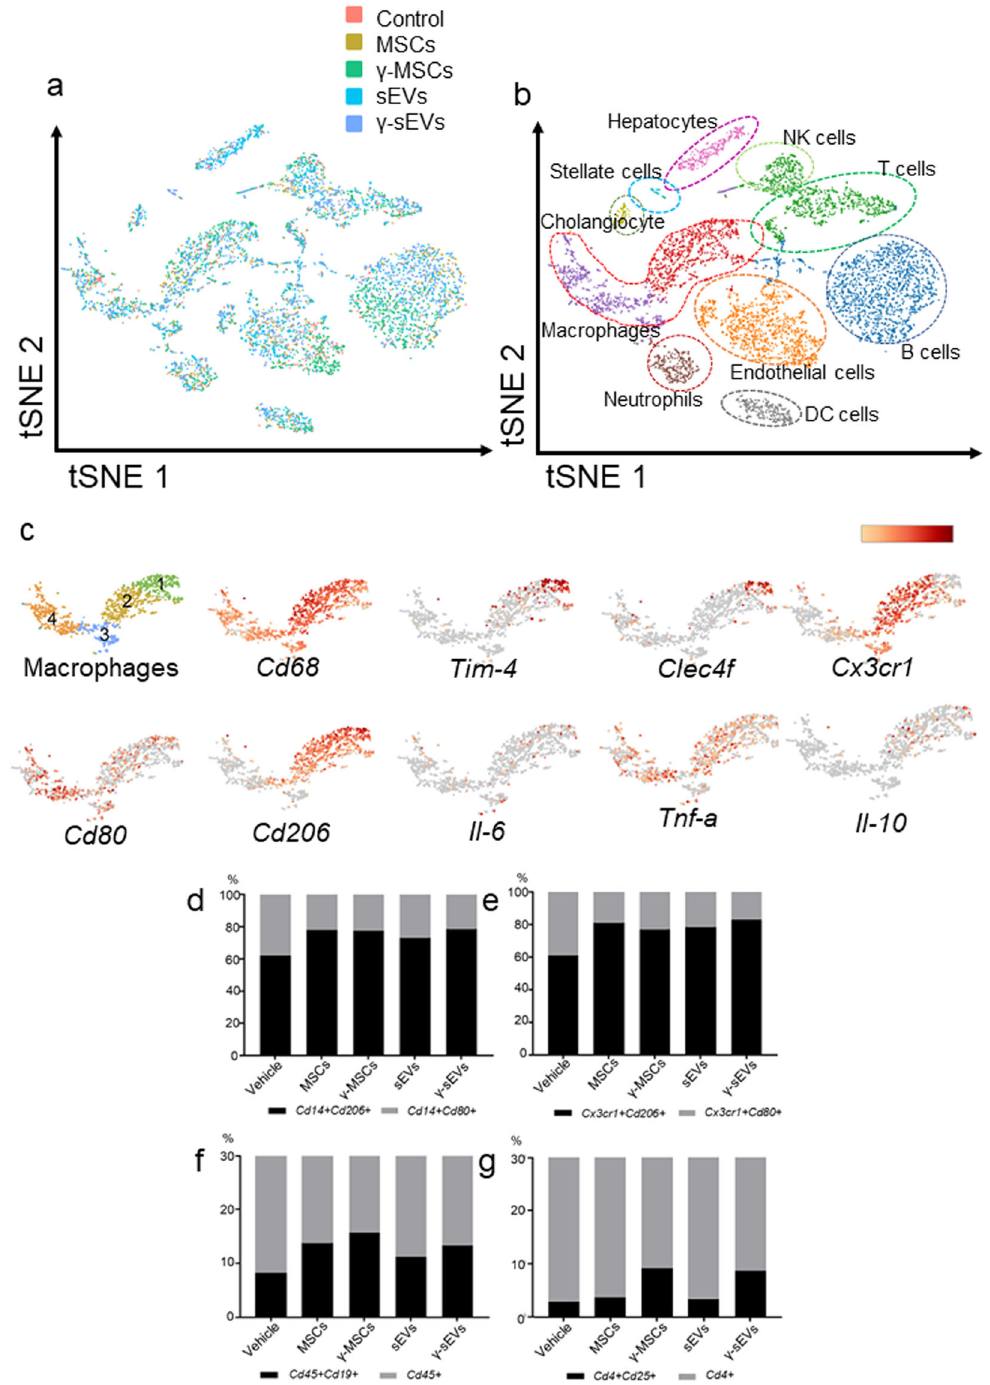
Fig. 4 Single-cell transcriptome analysis after injection of AD-MSCs (MSCs), γ -AD-MSCs ( γ -MSCs), AD-MSC-sEVs (sEVs), and AD-MSC- γ - sEVs ( γ -sEVs). a The t-distributed stochastic neighbor embedding (t-SNE) graph plotted by combining data for vehicle (PBS), MSC, γ -MSC, sEVs, and γ -sEVs. Red, brown, green, blue, and purple dots show the vehicle (663 cells), MSC (1215 cells), γ -MSC (1505 cells), sEV (1588 cells), and γ -sEV groups (1591 cells), respectively. b Representative cell characters in the clusters shown in a t-SNE plot. c Gene expression in selected macrophage populations. These macrophage populations were divided into four groups (1 – 4). d – g Frequency of Cd14 + Cd206 + and Cd14 + Cd80 + cells ( d ), Cx3cr1 + Cd206 + and Cx3cr1 + Cd80 + cells ( e ), Cd45 + Cd19 + cells in Cd45 + cells ( f ), and Cd4 + Cd25 + cells in Cd4 + cells ( g ) in the different among Cd45 + cells (Fig. 4f). Upon IFN- γ stimulation, the the Cd14 + and Cx3cr1 + cells. In all the MSC and sEV injection abundance of Cd4 + Cd25 + cells, which represent regulatory T groups, Cd206 + cells were abundant in both the Cd14 + and (Treg) cells in mice, increased among Cd4 + cells only in the γ -AD- Cx3cr1 + cell fractions (Fig. 4d, e). In addition, in all the MSC and MSC and AD-MSC- γ -sEV groups, implying that IFN- γ stimulated the sEV injection groups, the abundance of Cd19 + cells increased